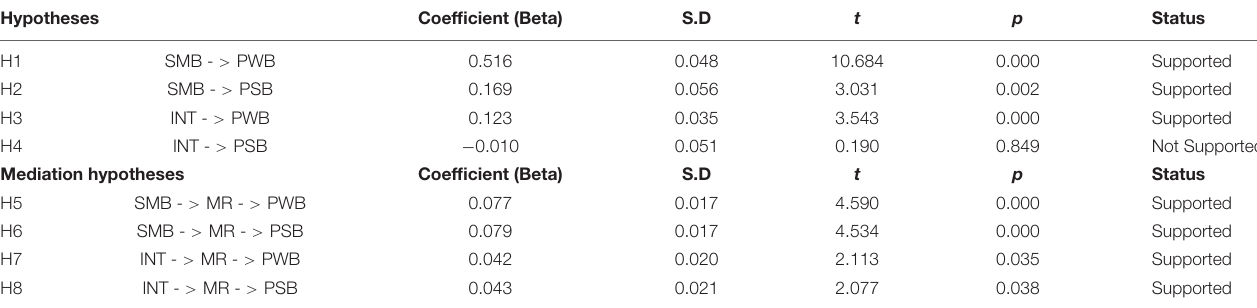
TABLE 5 | Hypotheses